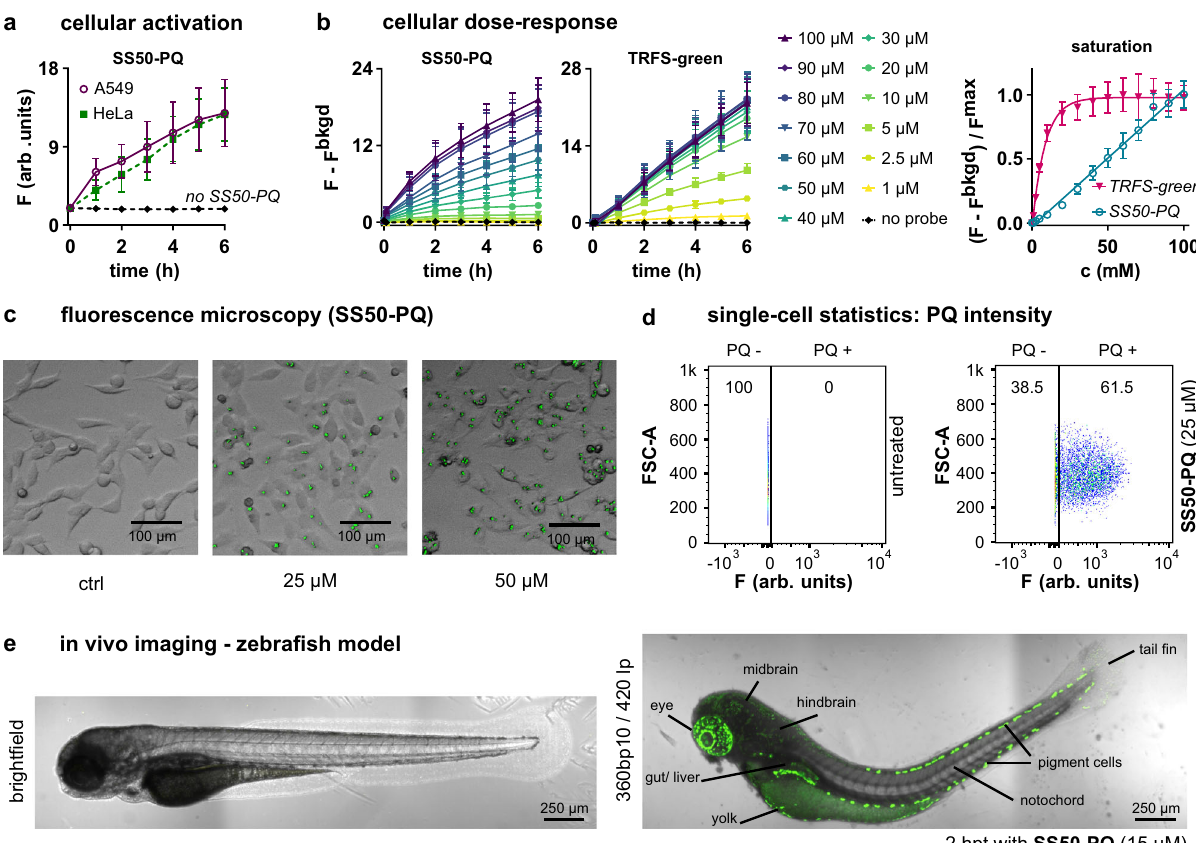
Fig. 4 The phenolic carbamate design of SS50-PQ gives reliable performance across biological assays. a Cellular fl uorescence timecourses of SS50-PQ in HeLa and A549 cells (50 µ M probe). b Dose-dependency of cellular fl uorescence timecourses with SS50-PQ , as compared to TRFS-green (HeLa cells). ( a , b : data as mean ± SD of ≥ 3 independent experiments). c Microscopy of SS50-PQ -treated HeLa cells shows fl uorescent intracellular solid precipitates of released PQ-OH (representative images from 3 independent experiments with similar results). d Flow cytometry-based single-cell statistics of cellular fl uorescence after SS50-PQ treatment (25 µ M; Jurkat T-cells). ( c , d : representative examples of ≥ 3 independent experiments with similar results). e Fluorescence imaging of embryonic zebra fi sh before and after SS50-PQ treatment (representative example of 3 independent experiments). ( c , e : bright fi eld transmission image in greyscale, fl uorescence superimposed in